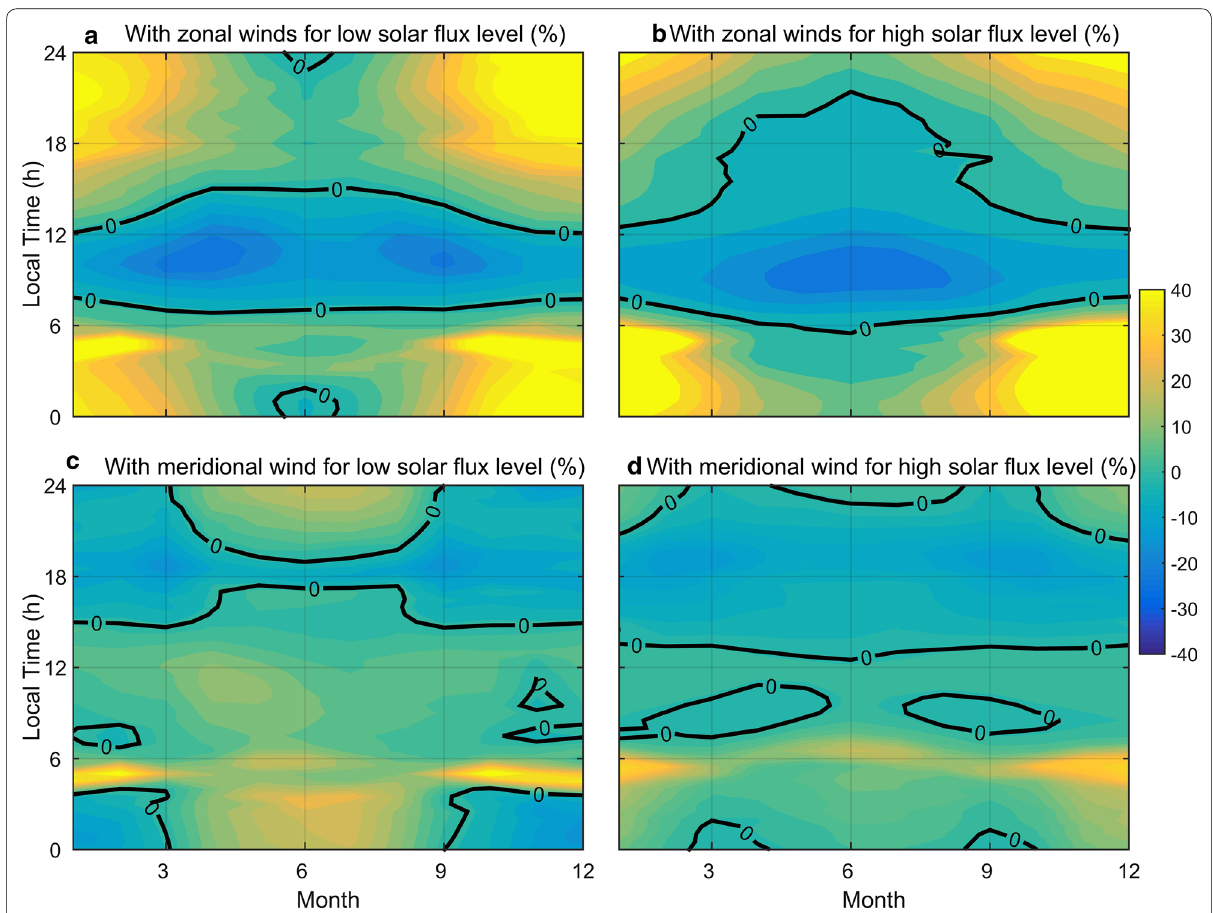
Fig. 5 The seasonal and diurnal variations of R ew (in units of %) driven by a , b thermospheric zonal wind and by c , d thermospheric meridional wind. The left and right plots, respectively, show the east–west differences for a , c low and b , d high solar flux levels. The solid lines in these plots represent the zero